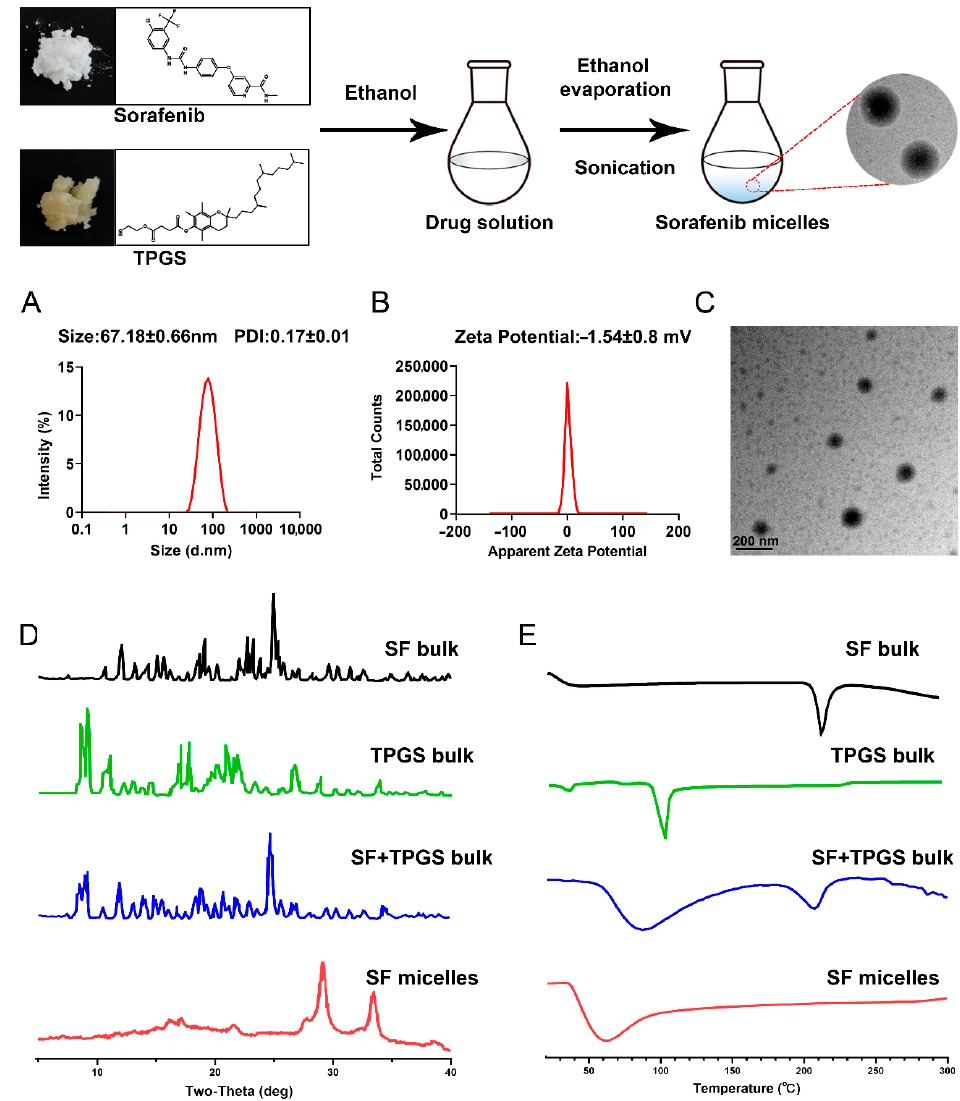
Figure 1. SF micelles characterization. ( A ) Size distribution and ( B ) zeta-potential of SF micelles. ( C ) TEM image (bar = 200 nm). ( D ) XRPD patterns. ( E ) DSC curves.